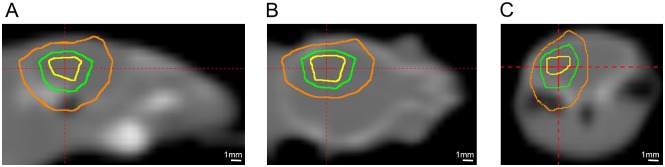
Gamma-Knife dose radiation contours superimposed on a CT image of a mouse.Panels A, B, and C show sagittal, coronal, and transaxial views, respectively. The three contours shown are at 75% (yellow), 50% (green), and 25% (orange) isodose. The red cross-hairs in each panel identify the location of the imaging planes shown in the other two panels.